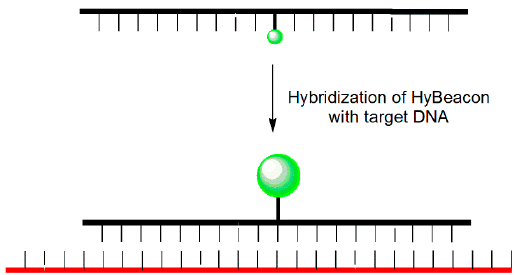
Figure 9. HyBeacon probe.